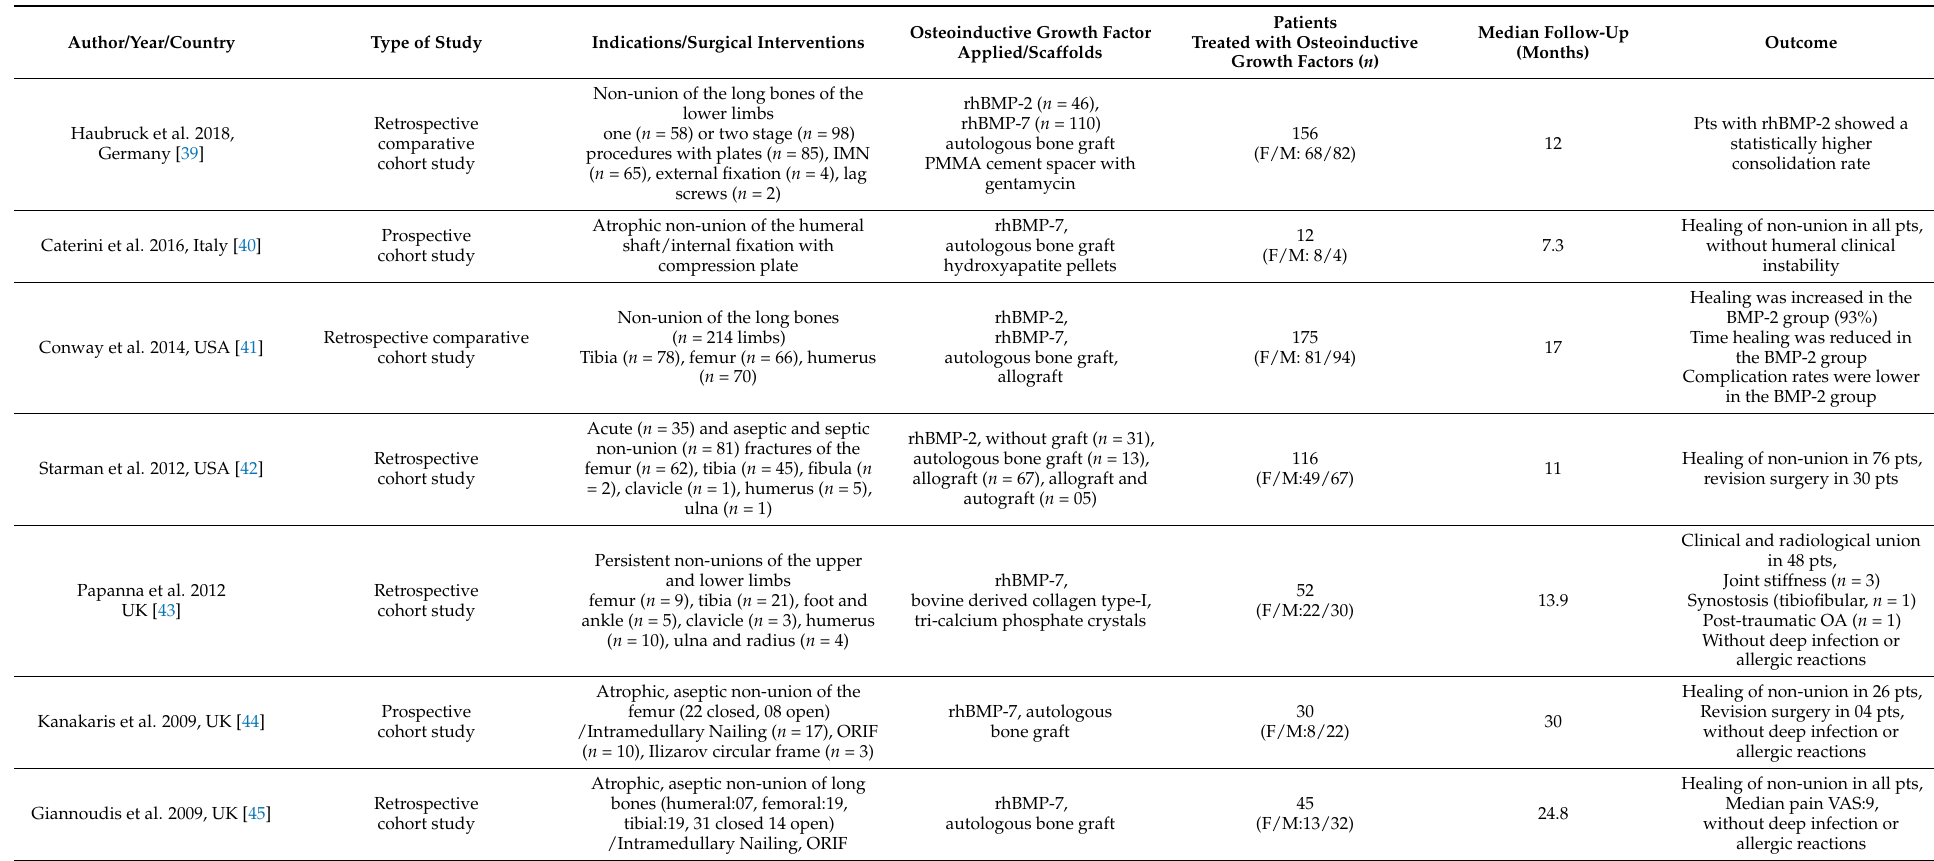
Table 2. Clinical data of studies included for qualitative examination demonstrating significant results for long bone fracture healing treatment after application of osteoinductive growth factors (pts: patients, rh: recombinant